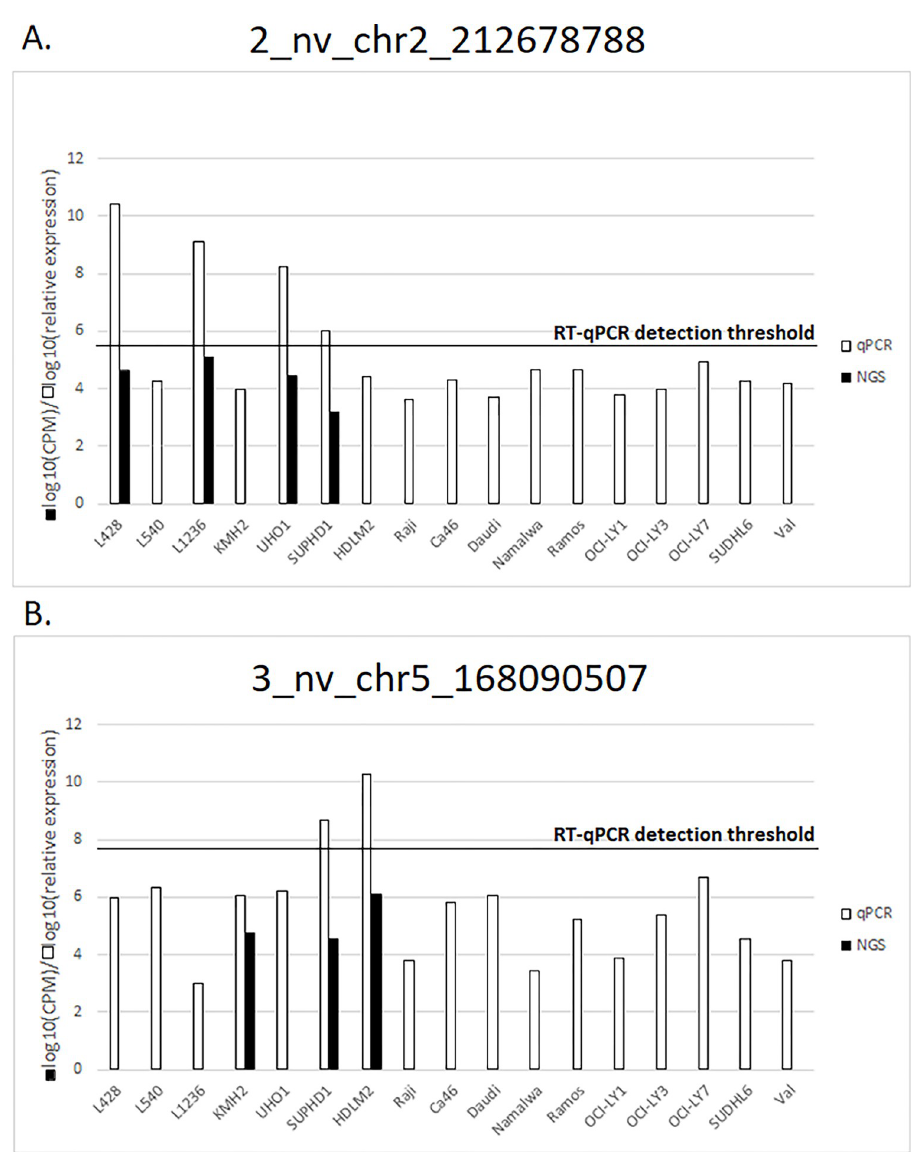
Fig 2. The comparison of log10 normalized relative expression of validated miRNAs. Black bars represent NGS experiment (CPM) and white bars the RT-qPCR relative expression. The RT-qPCR detection thresholds were obtained by adding the standard deviation of the RT-qPCR results to the mean relative expression level for each miRNA, respectively.